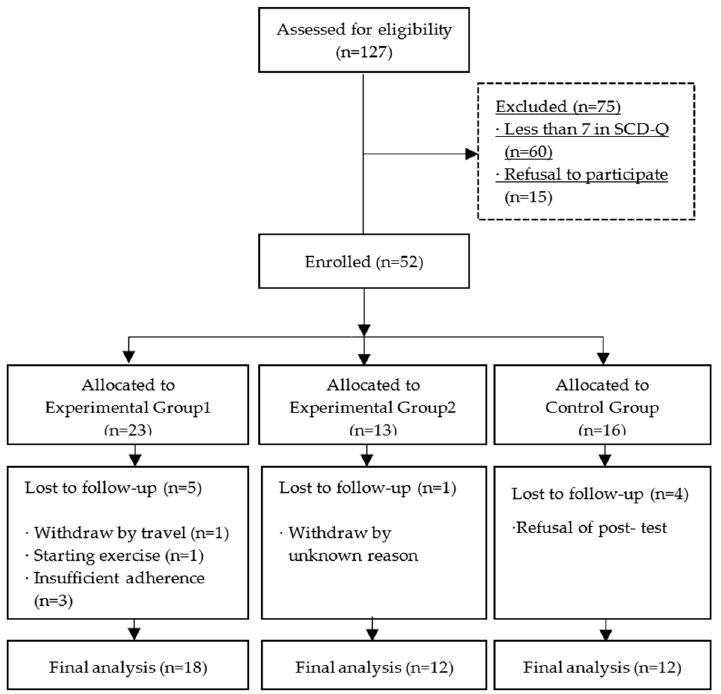
Figure 1. Flow chart of participants.